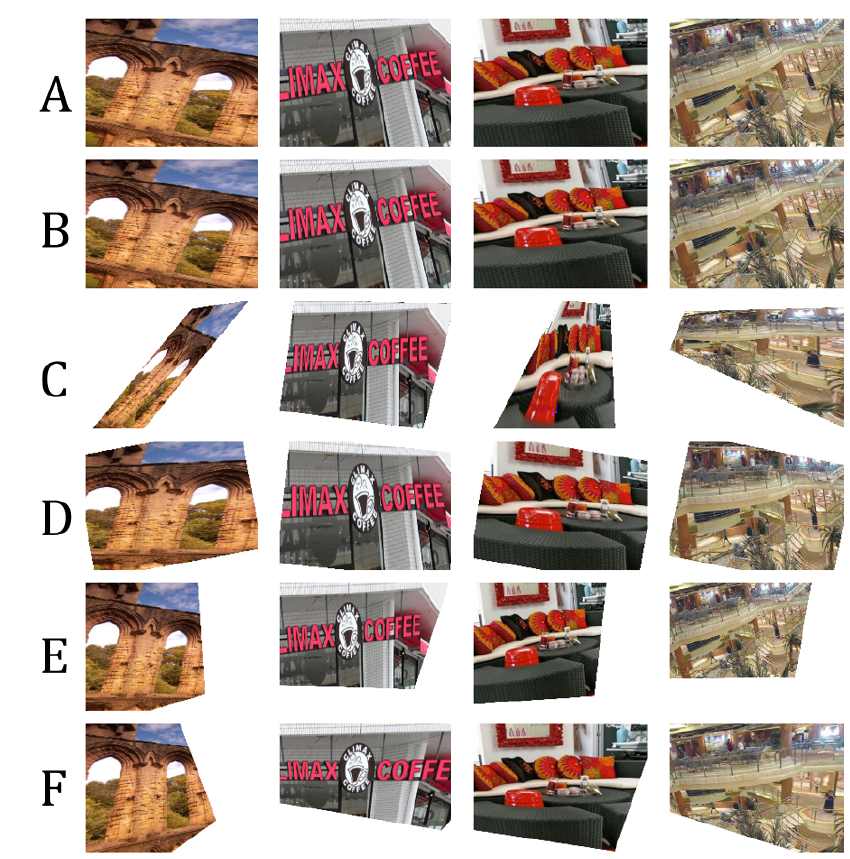
Figure 14. Limitations of our method on unseen images. ( A ): Distorted input images. ( B ): Corrected image using homography estimation ( C ): Corrected image using the technique of Chaudhury et al. [21]. ( D ): Corrected image using the technique of Li et al. [11]. ( E ): Corrected image using our method. ( F ): Ground-truth.